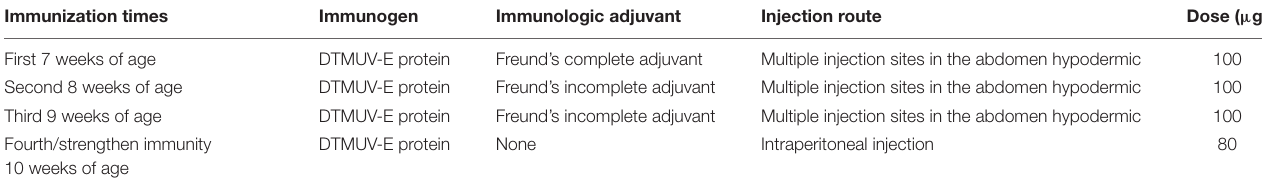
TABLE 1 | The immunization procedure for BALB/c